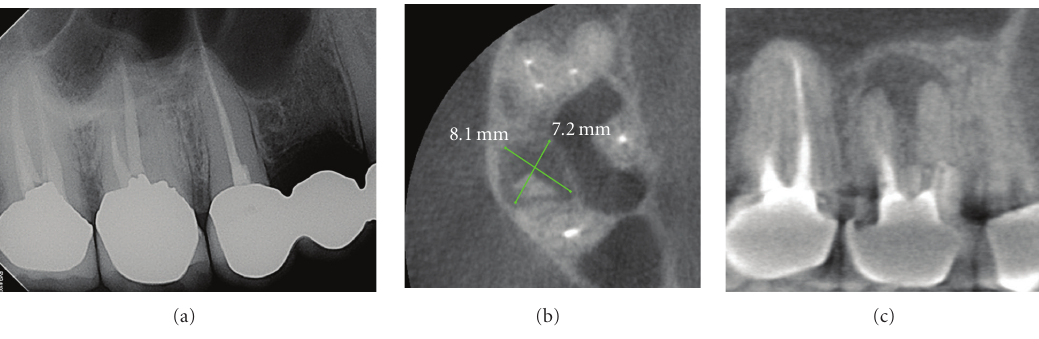
Figure 11: This patient was referred for discomfort and swelling in the maxillary right quadrant. While an initial periapical radiograph (a) clearly demonstrated an untreated mesial root in the maxillary first molar, periradicular periodontitis was undetectable. CBCT images ((a) axial, (b) sagittal) clearly identify a large apical radiolucent lesion associated with the mesial root extending to the distobuccal root. The tooth was retreated and the symptoms subsided.